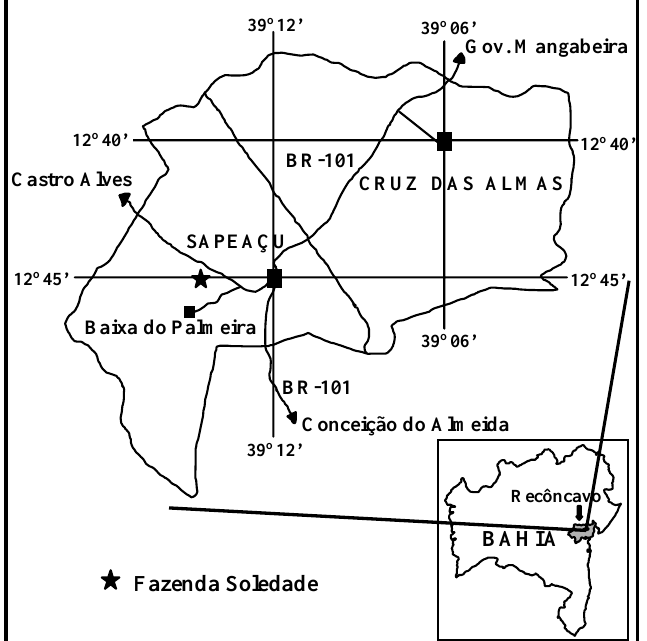
Figura 1. Localização da Fazenda Soledade, em Sapeaçu (BA), onde está situada a toposseqüência